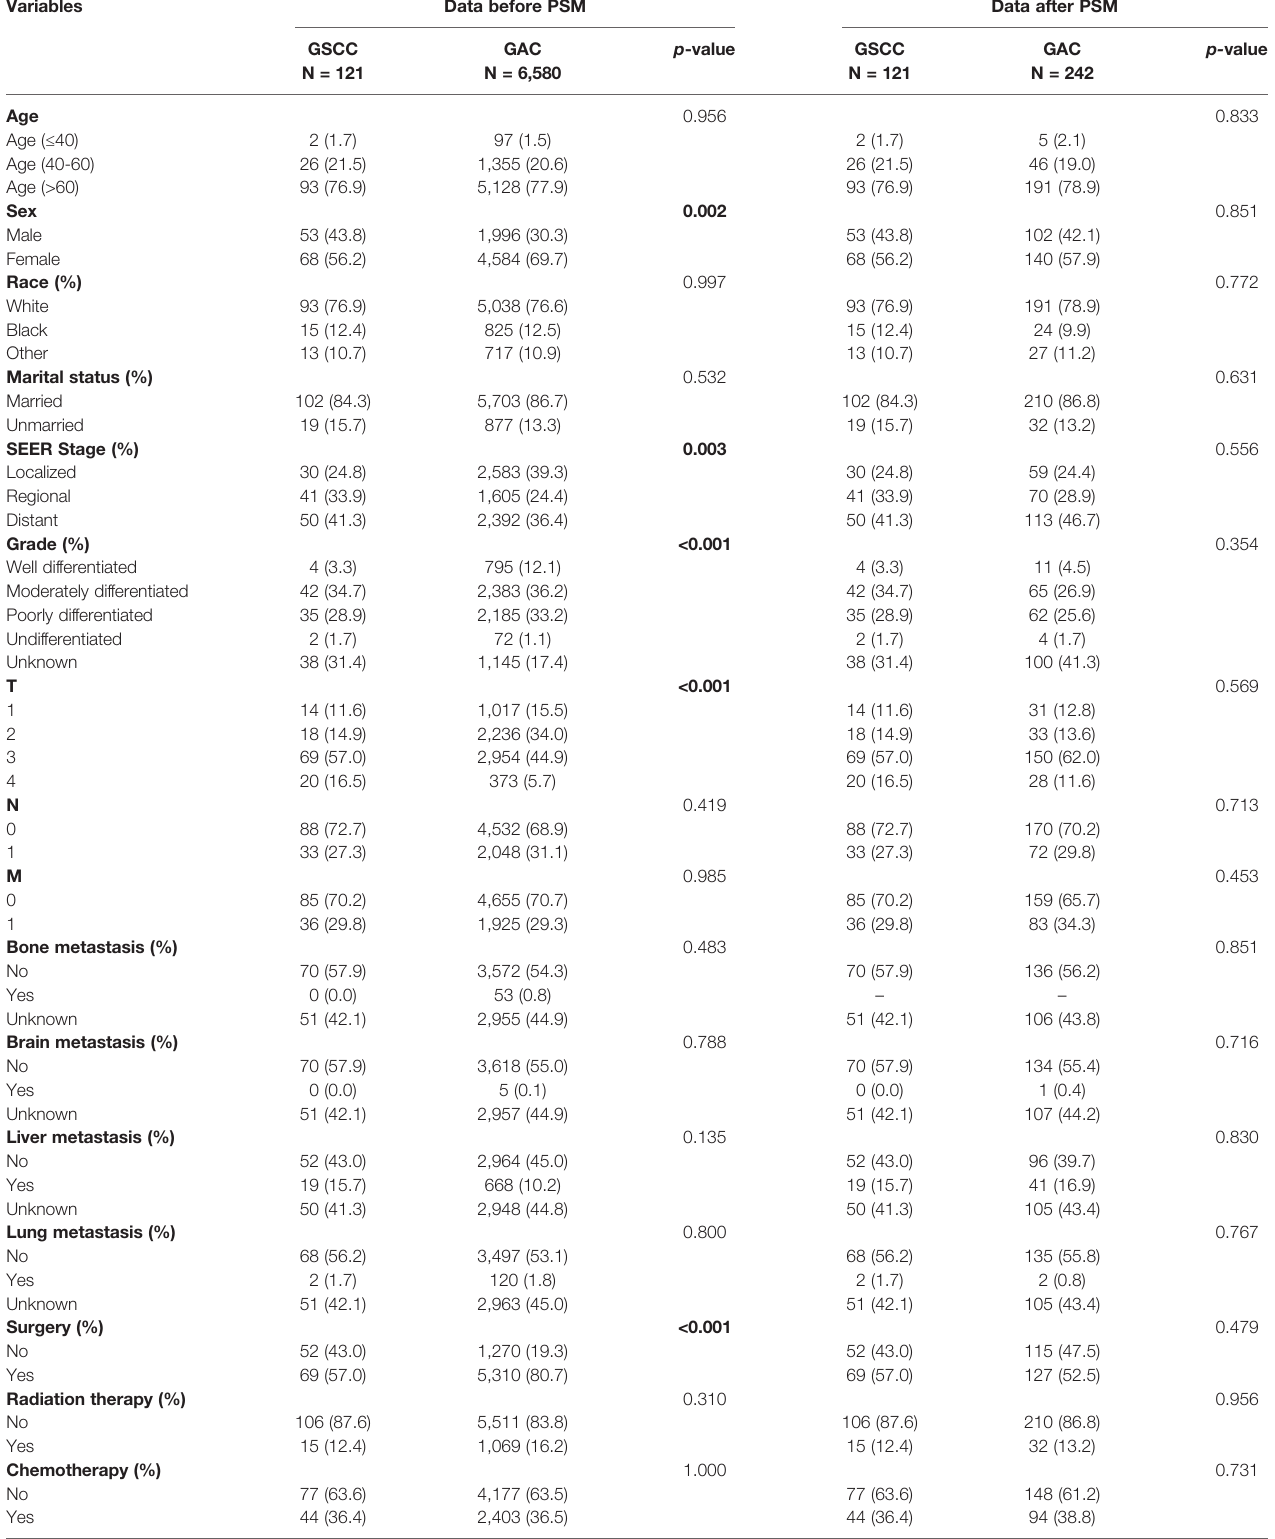
TABLE 1 | Demographics and clinicopathological characteristics of GSCC and GAC patients.